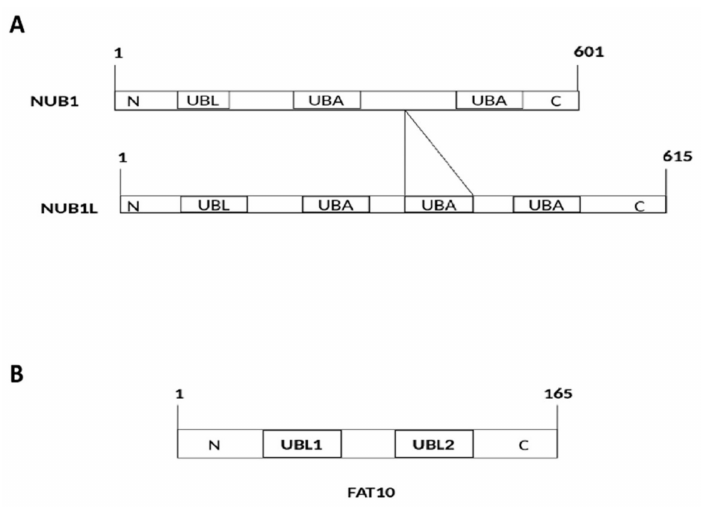
Figure 1. ( A ) Structural and functional domains of NEDD8 ultimate buster-1 (NUB1) and NEDD8 ultimate buster-1 long (NUB1L). UBL: Ubiquitin-like domain (interacts with proteasome); UBA: Ubiq- uitin associated domain (interacts with ubiquitin-related enzymes). An additional UBA (14 amino acids) domain in NUB1L. ( B ) Structural and functional domains of F-adjacent transcript 10 (FAT10). FAT10 comprises 165 amino acids. UBL: Ubiquitin-like domain (interacts with VWA domain of 26S